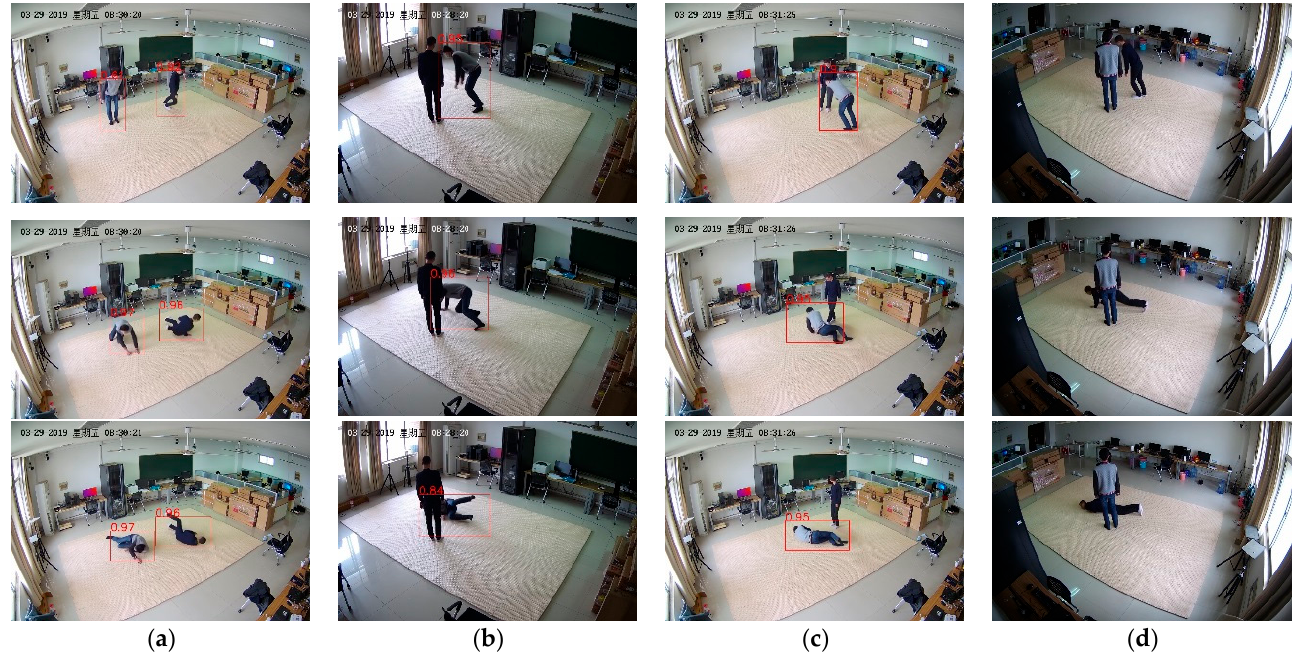
Figure 7. Four instances of the human fall process in the experiment with two persons in the scene: ( a ) Two persons who are not next to each other fall; ( b ) One person behind another fall; ( c ) One person in front of another fall; ( d ) One person mostly occluded by another fall.